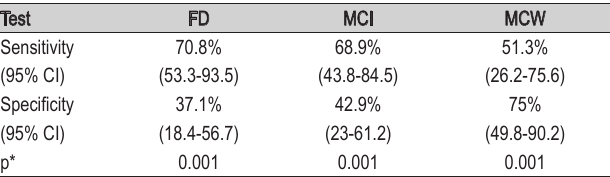
Table 1 - Diagnostic performance of FD, MCI and MCW for screening low BMD.